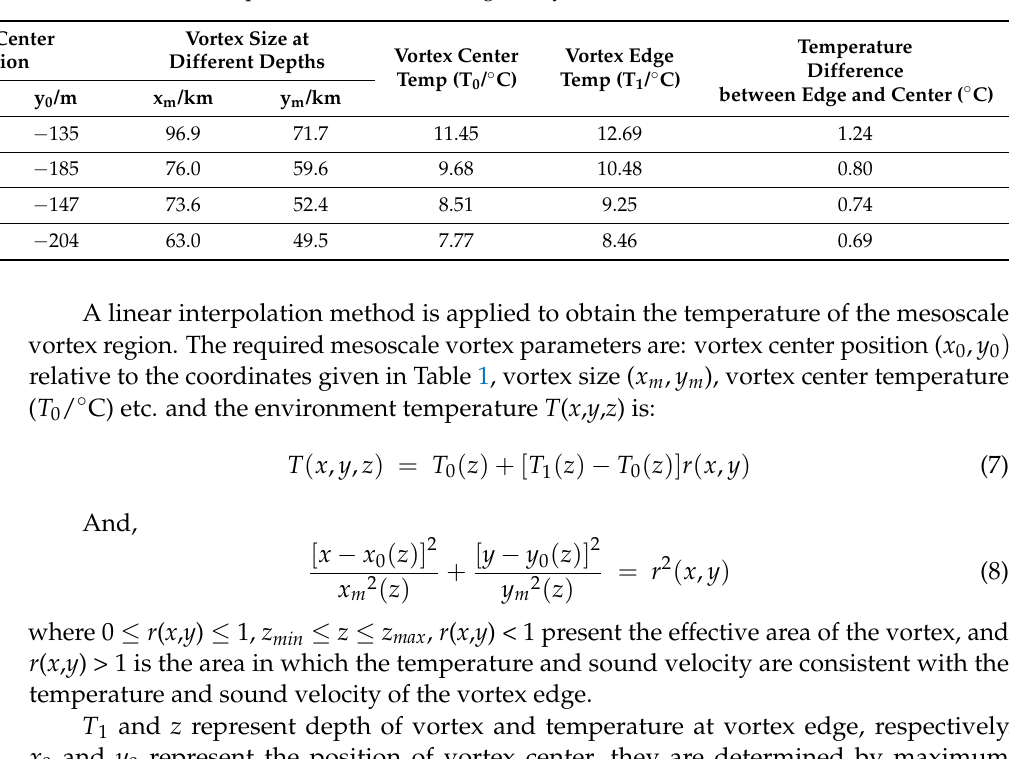
Table 2. Vortex parameters based on Argo Buoy data.